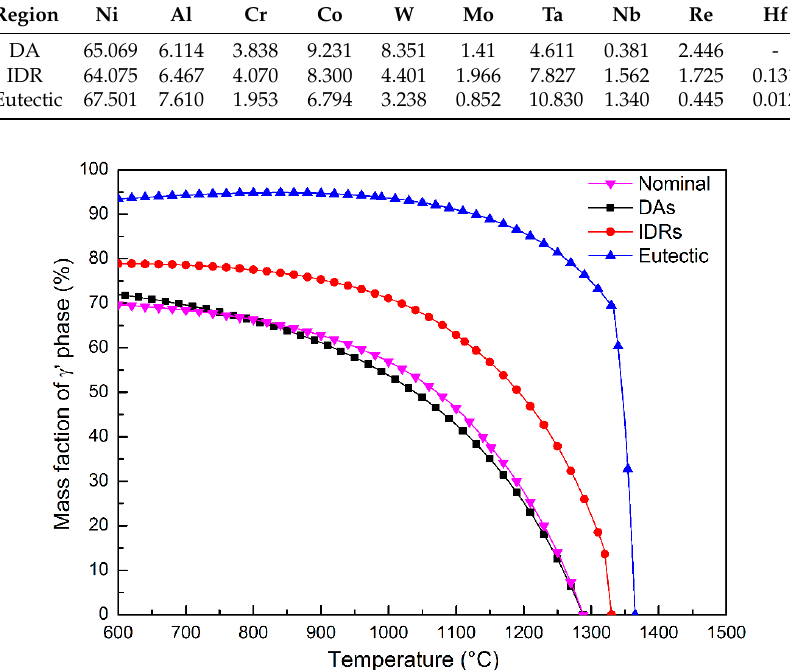
Figure 10. Solution behavior of γ ’ phase in DAs, IDRs and eutectics obtained from thermodynamic